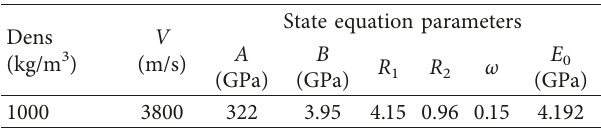
Table 4: Explosive parameters.